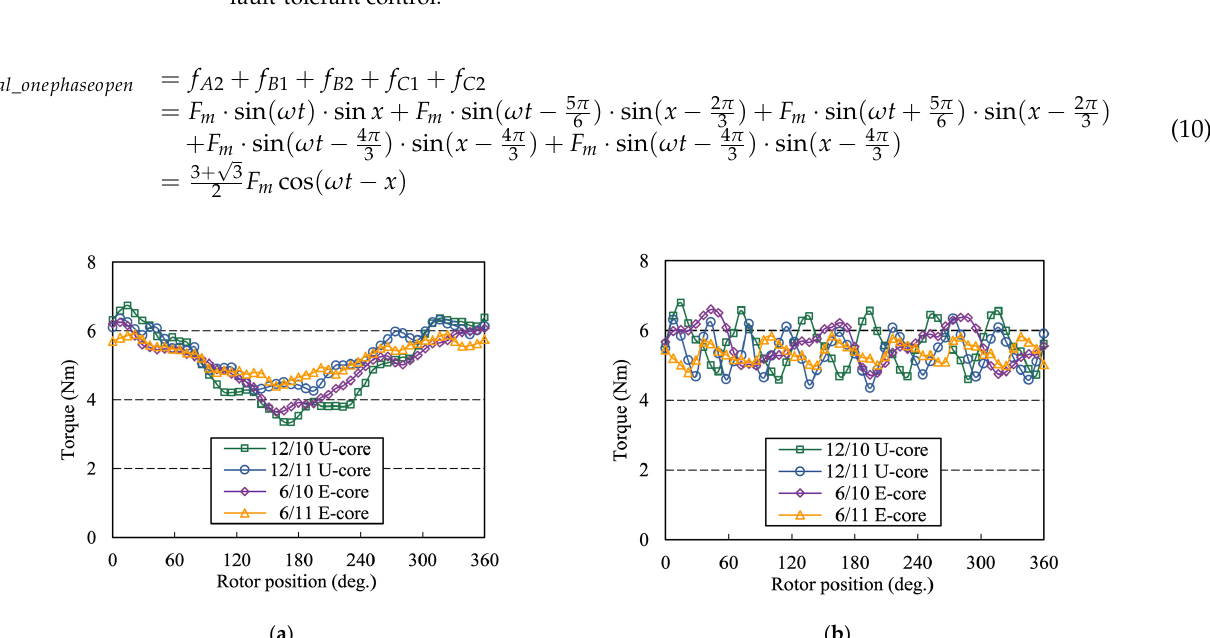
Figure 11. Electromagnetic torque under one-phase open-circuit and fault-tolerant control operation condition of four candidates. ( a ) One-phase open-circuit; ( b ) fault-tolerant control operation.